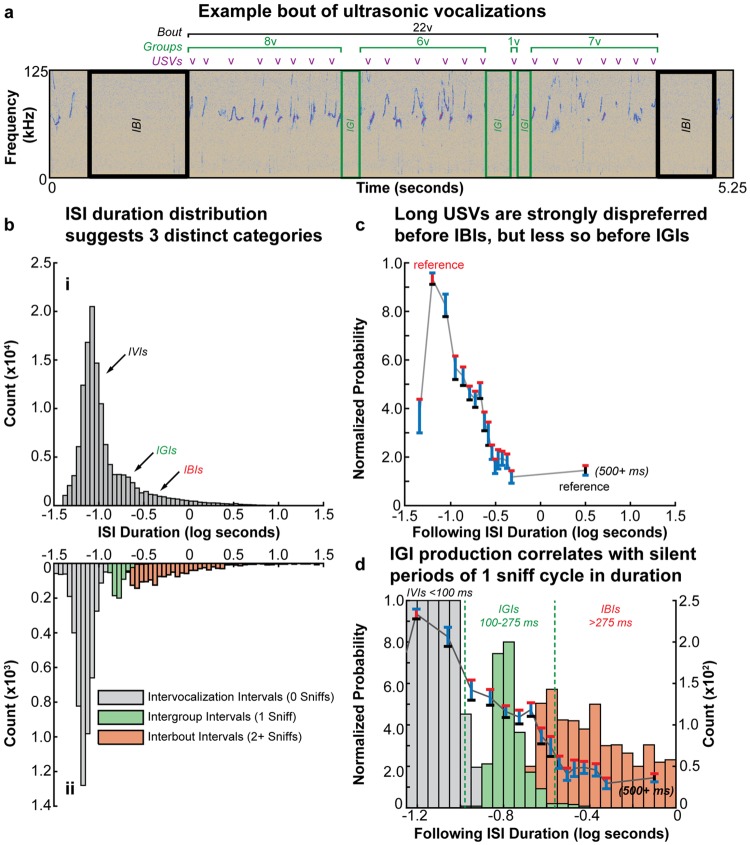
Intervening silent interval classes exhibit unique features.(a) Example spectrogram showing a bout of 22 USVs produced by an adult mouse. Three distinct ISI categories were observed: short duration IVIs separating individual USVs, medium duration IGIs separating groups of USVs, and long duration IBIs separating bouts of USV groups. (b.i) Pooled histogram of ISI durations produced by all 19 mice in all adult recording sessions. (b.ii) Pooled histogram of ISI durations from 11 adult mice from all freely moving plethysmography sessions. ISIs arising from silent inhalations (0 complete sniff cycles), 1 nonvocal sniff cycle, or 2+ nonvocal sniff cycles are indicated; the corresponding distributions in (b.i) are indicated with arrows. (c) The normalized probability of observing a long USV as a function of following ISI duration. Long USV production was most likely prior to IVIs 50-75 ms (red vertical bar) in duration and least likely prior to IBIs 500+ ms in duration (black vertical bar). However, a plateau of intermediate probability which was significantly higher than prior to IBIs (black lower error bars) and significantly lower than prior to IVIs (red upper error bars) was observed for ISIs 100-275 ms in duration, which were designated as IGIs (p < 0.05, repeated measures one-way ANOVA with Dunnett’s correction for multiple comparisons; see S6 Table for additional statistical details). (d) The plot in (c) superimposed over the histogram in (b.i); the plateau of intermediate long USV production probability (IGIs) corresponds to silent intervals arising from a single nonvocal sniff cycle. In (c-d), error bars indicate the mean across animals +/-1 standard error.